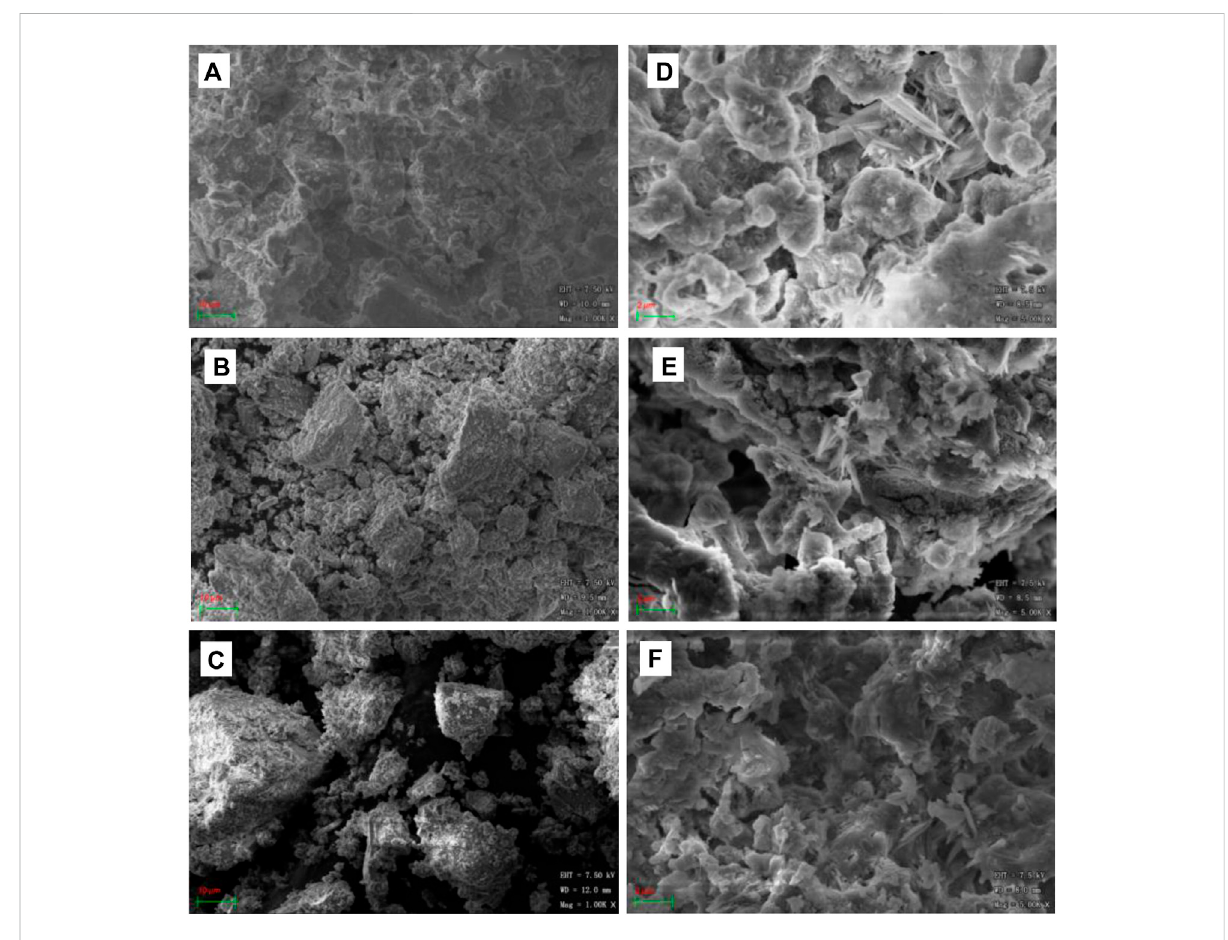
FIGURE 11 SEM images of morphologies of cement-GGBFS hydration products. (A – C) : S2, S4, and S6 at 7 days; (D – F) : S2, S4, and S6 at 28